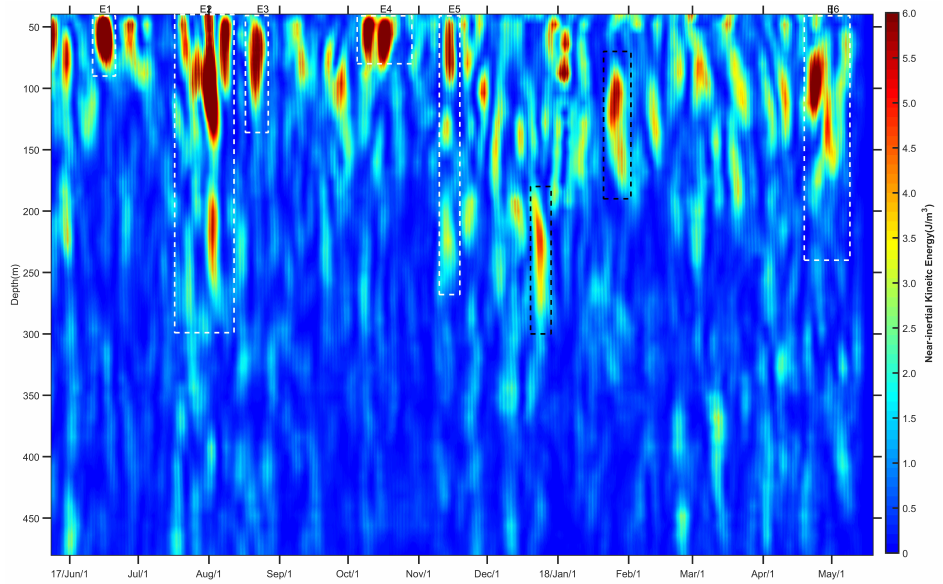
Figure 2. Depth–time plot of the inertial period averaging near-inertial kinetic energy. The white rectangles denote the significant episodes with NIKE exceeding one standard deviation. The black rectangles represent the episodes of NIWs happening in the ocean